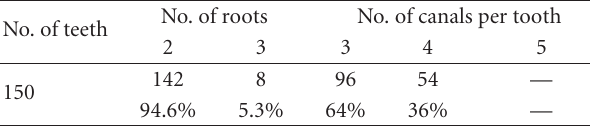
Table 1: Number of roots and canals in mandibular first